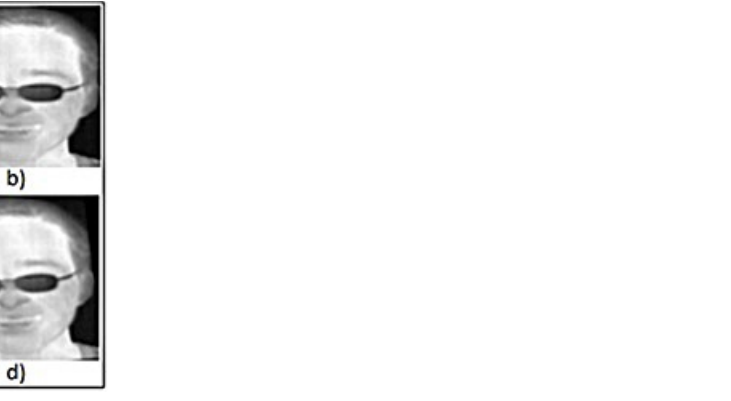
Figure 3. Selection of ROIs for three proposed classi fi cation models: ( a ) represents 6 main ROIs, ( b ) represents 27 sub-ROIs decomposed from 6 main ROIs, ( c ) represents selective 11 sub-ROIs from 27 sub-ROIs.